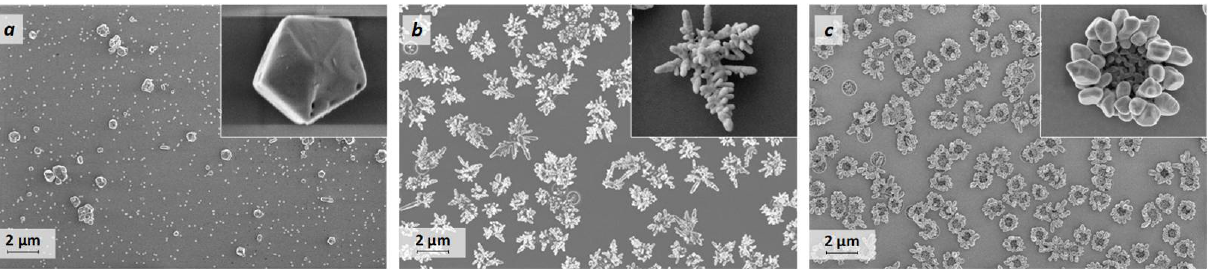
Figure 2. SEM planar images of silver nanostructures grown in SiO 2 pores with diameters D at the moment of pore opening (320 nm) ( a ); 800 nm ( b ); 1000 nm ( c ). The insets to the figures show enlarged images of structures with morphology typical for the selected deposition regimes.